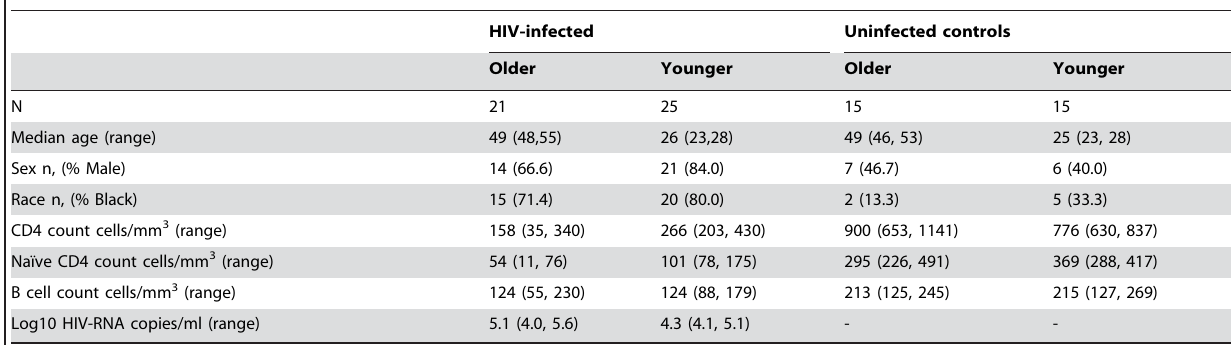
Table 1. Baseline characteristics of study participants.